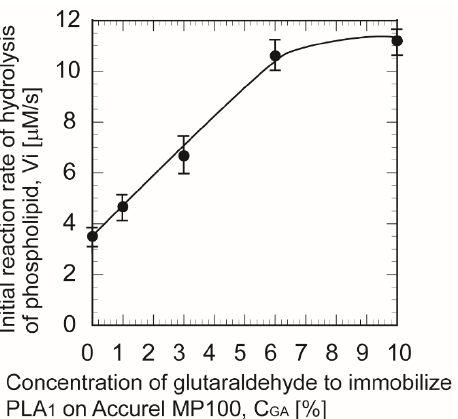
Figure 6. Effect of immobilized phospholipase A 1 with glutaraldehyde treatment on the initial reaction rate.